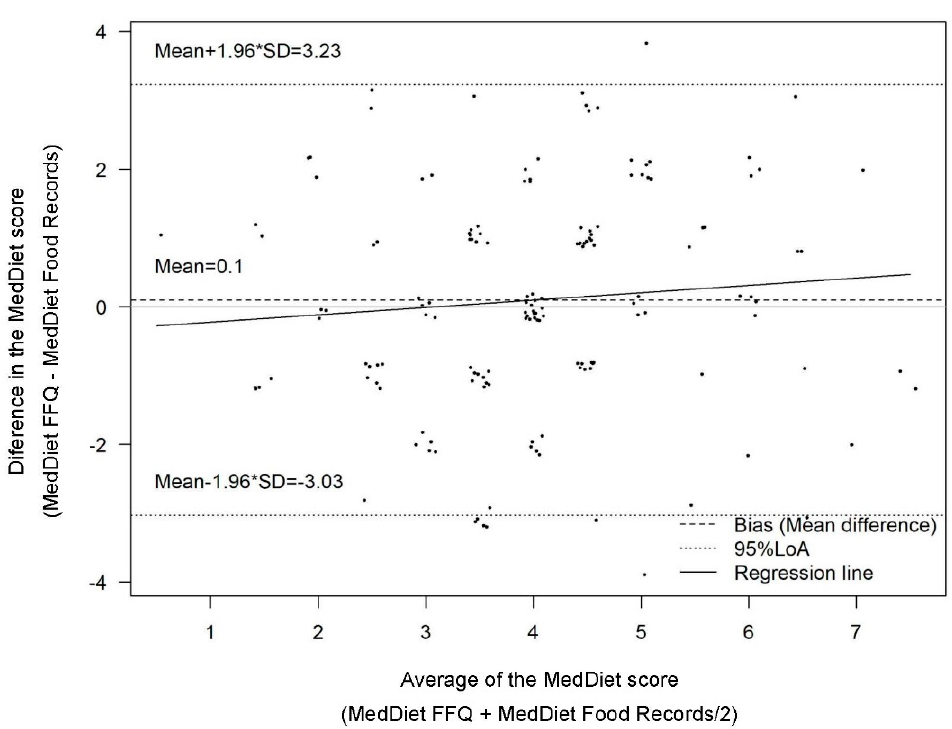
Figure 1. Bland-Altman plot for the agreement of the MedDiet score derived from the food frequency questionnaire and the reference method ( n = 150).